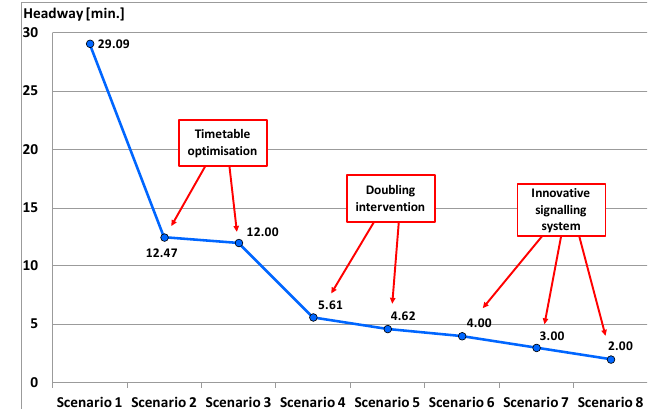
Fig. 3. Simulation results in terms of headway for each scenario analysed.